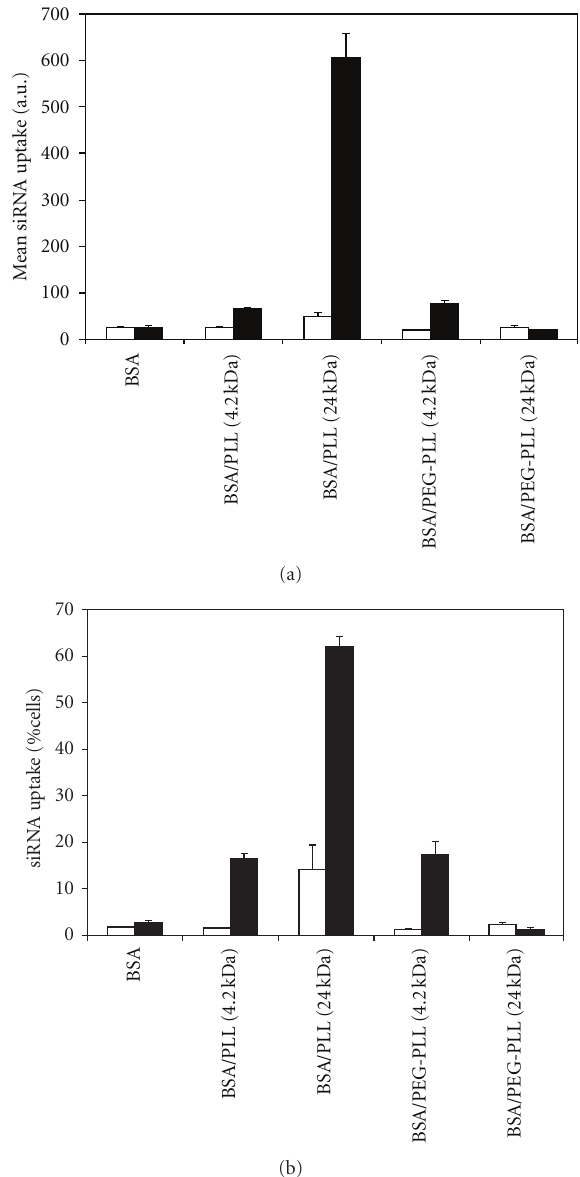
Figure 4: Data summarizing the mean uptake and percent cellular uptake of labeled and unlabeled siRNA. (a) Mean (+1 SD) FAM fluorescence of the cells exposed to NPs without siRNA ( (cid:2) ) and with siRNA ( (cid:3) ). BSA NPs coated with 24 kDa PLL showed the greatest cellular uptake. (b) Mean (+1 SD) siRNA-positive cells when the cells were exposed to NPs without siRNA ( (cid:2) ) and with siRNA ( (cid:3) ). BSA NPs coated with 24 kDa PLL showed the greatest value of siRNA-positive cell population. The value in parentheses represents the molecular weight of the PLL in